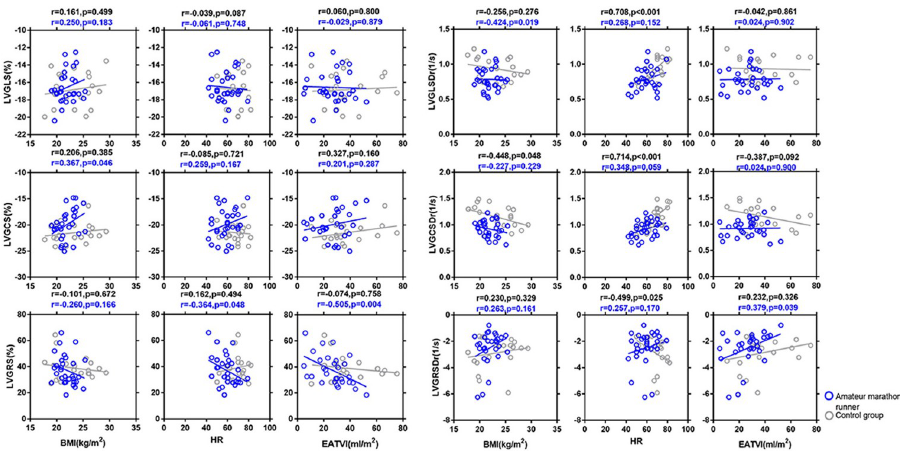
Fig 3. Simple correlations between the cardiac magnetic resonance parameters of left ventricular global radial strain (LVGRS), left ventricular global circumferential strain (LVGCS), left ventricular global longitudinal strain (LVGLS), left ventricular global radial strain of diastolic rate (LVGRSDr), left ventricular global circumferential strain of diastolic rate (LVGCSDr), and left ventricular global longitudinal strain of diastolic rate (LVGLSDr), respectively with body mass index (BMI), heart rate (HR), and epicardial adipose tissue volume index (EATVI) in the amateur marathon runners and control group. A simple regression analysis was made separately in amateur marathon runners (blue circles and lines) and control group (black circles and lines). The R and P-values are shown. LVGRS, left ventricular global radial strain; LVGCS, left ventricular global circumferential strain; LVGLS, left ventricular global longitudinal strain; LVGRSDr, left ventricular global radial strain of diastolic rate; LVGCSDr, left ventricular global circumferential strain of diastolic rate; LVGLSDr, left ventricular global longitudinal strain of diastolic rate; BMI, body mass index; HR, heart rate; EATVI, epicardial adipose tissue volume